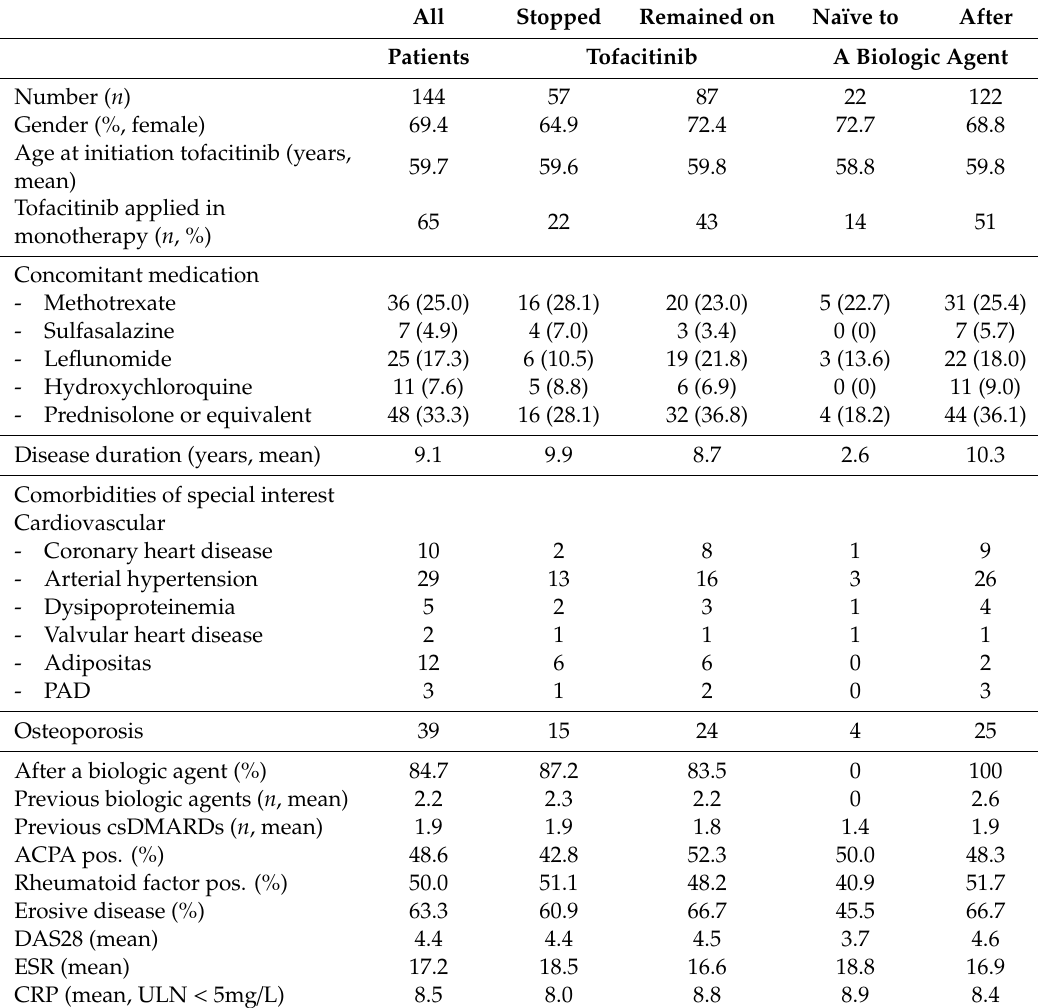
Table 1. Patient